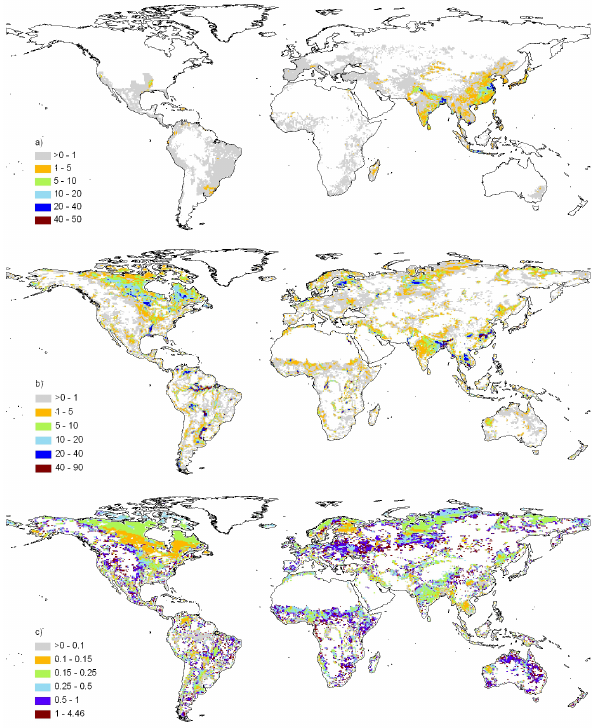
Fig. 1. Annual average growing area of irrigated rice, in percent of cell area (a) , annual average naturally inundated area (average over all months between January 1993 and December 2004) based on Papa et al. (2010) and Portmann et al. (2010), in percent of cell area (b) , and variability of naturally inundated areas as expressed by the coefficient of variation (c) . Irrigated rice and surface water extent values are aggregated to 0.5 ◦ cells.